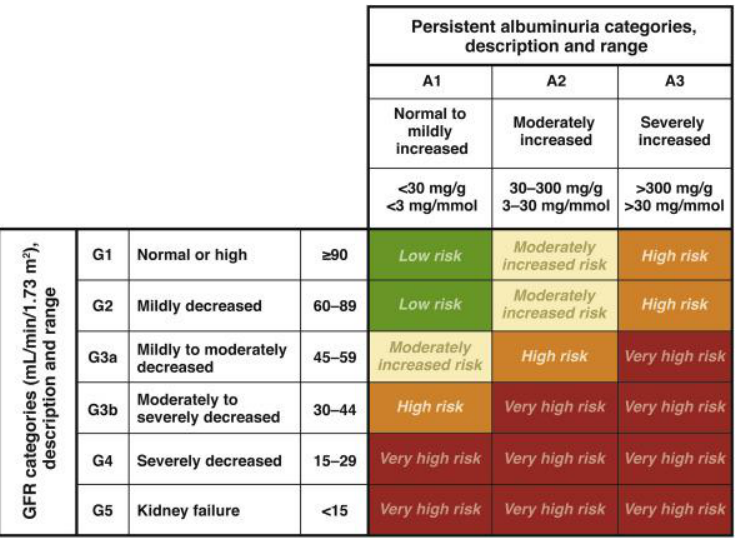
Figure 1. CKD grade was determined with KDIGO as indicated by the National Kidney Foundation